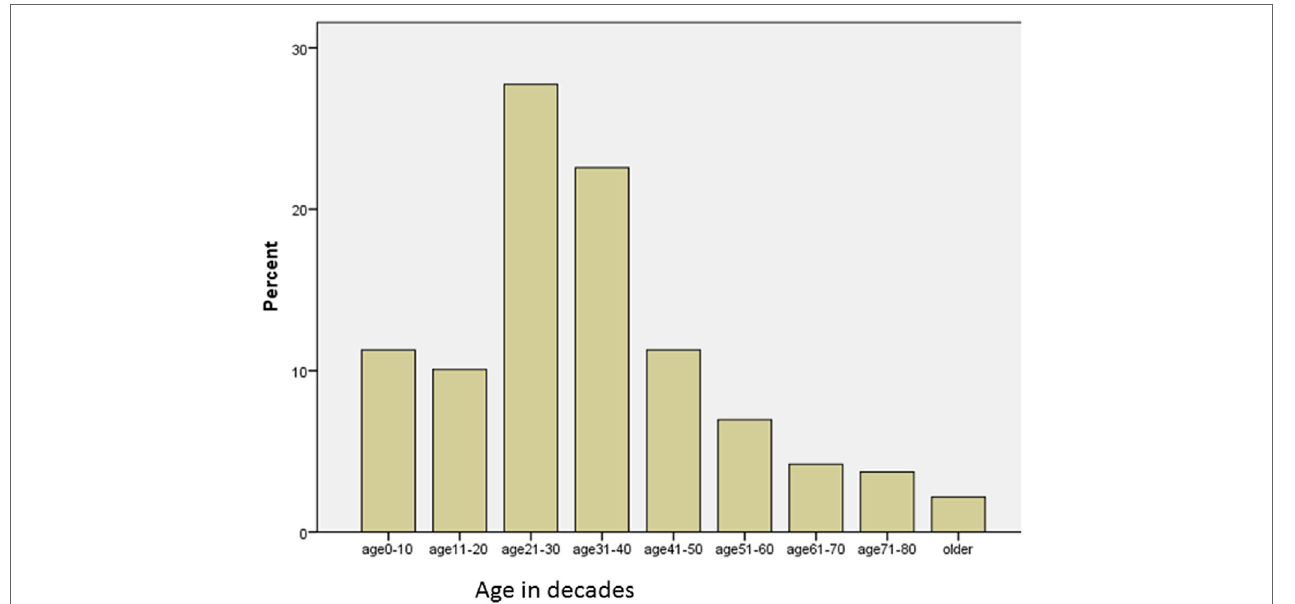
FigUre 1 | Road trauma-related head injury from Nigeria: age distribution of the victims in this